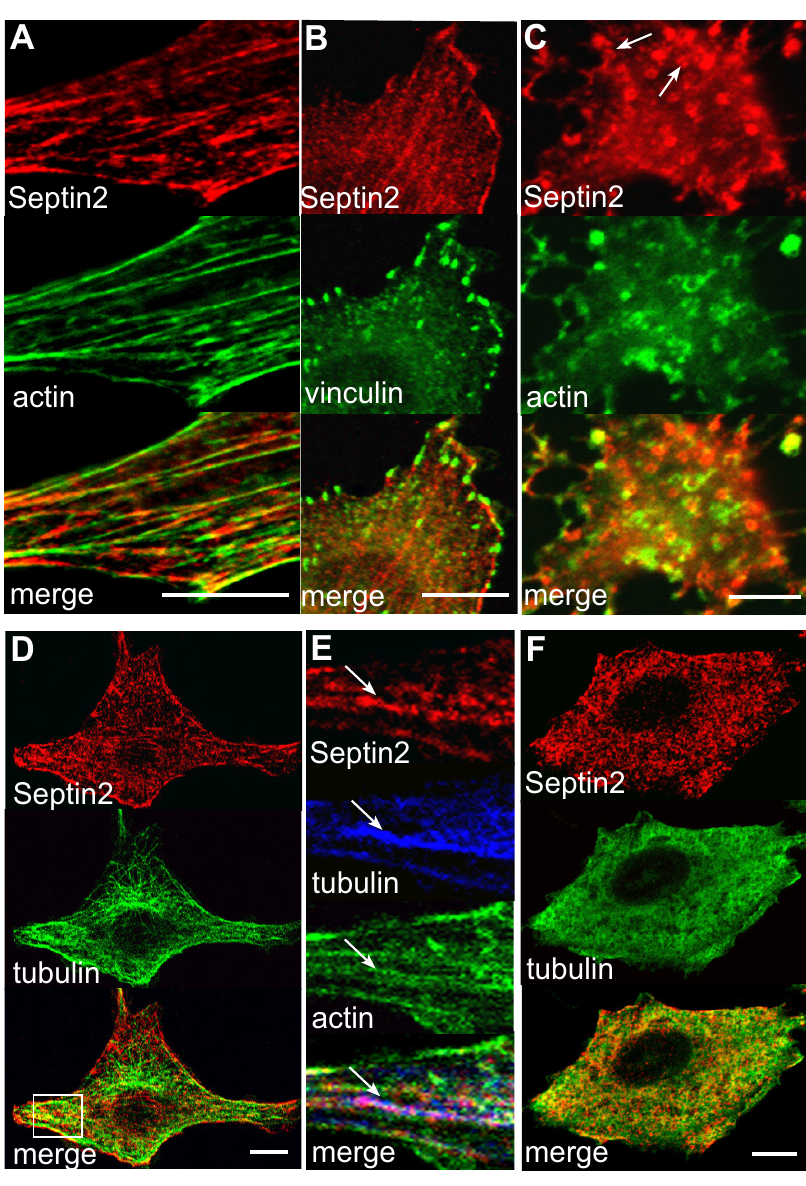
Septin2 interacts with actin, but not with tubulin. (A) Immunofluorescence of endogenous Septin2 (red) and actin (green, stained with phallacidin) in interphase NRK cells. Note the typical filamentous-granular organisation of Septin2 and its co-localisation with actin. (B) Septin2 (red) does not colocalise with endogenous vinculin (green), a marker for focal adhesions. (C) Staining of Septin2 (red) and actin (green) after disruption of the actin cytoskeleton. NRK cells were treated with Latrun- culin B for 30 min. Septin2 now forms rings. (D) Septin2 (red) and tubulin (green) mainly have distinct distributions in NRK cells. (E) Enlarged image of the boxed region in D. Regions with overlapping Septin2 (red) and tubulin (blue) staining always contain actin (green) as well (arrow). (F) Cells were treated with nocodazole for 30 min. Microtubule organisation (green) is disturbed, but Septin2 (red) distribution is largely unaffected. All images show a single confocal section. Bars, 10 µ